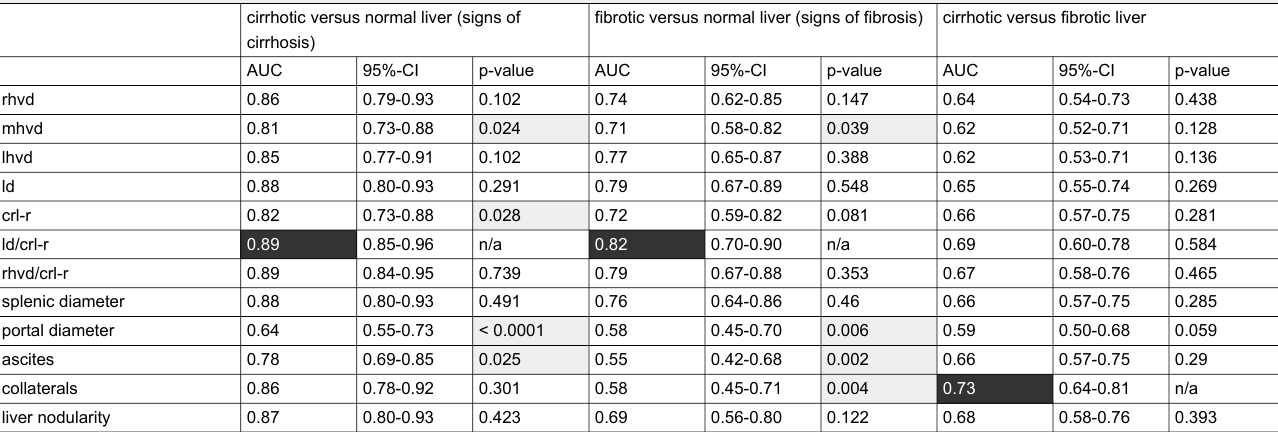
Table 1: Quantitative and qualitative computed tomographysigns for the fibrosis and cirrhosis groups. Threshold levels, sensitivity and specificity for fibrosis and cirrhosis (with 95% confidence intervals).